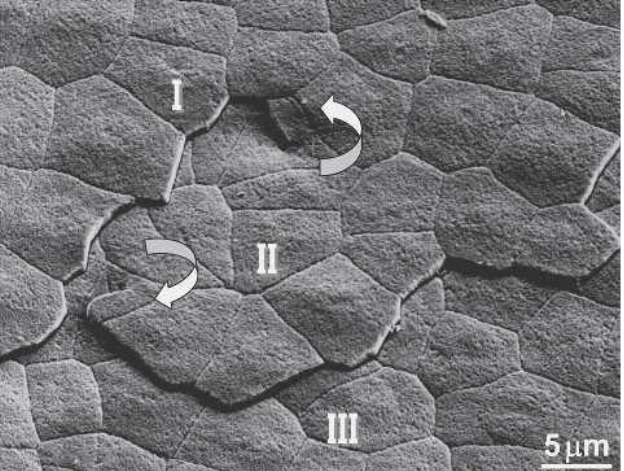
Figure 7. SEM image showing two screw dislocations and spiral growth associated with three layers in nacre. The center core and corresponding spiral growth domain are oriented counterclockwise connecting layer I and II; the core and corresponding domain at bottom left are clockwise relating to layer II and III. This shows how the layers are forming simultaneously on top of one another. Reproduced from [1] with permission from Cambridge University